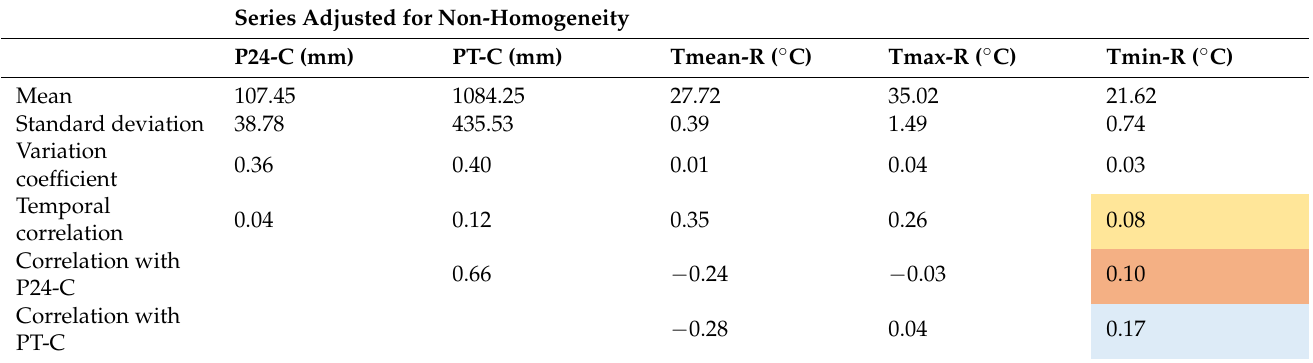
Table 4. Effects of non-homogeneity on the statistical parameters of the series. See Table 1 for the original series and Appendix A for the complete